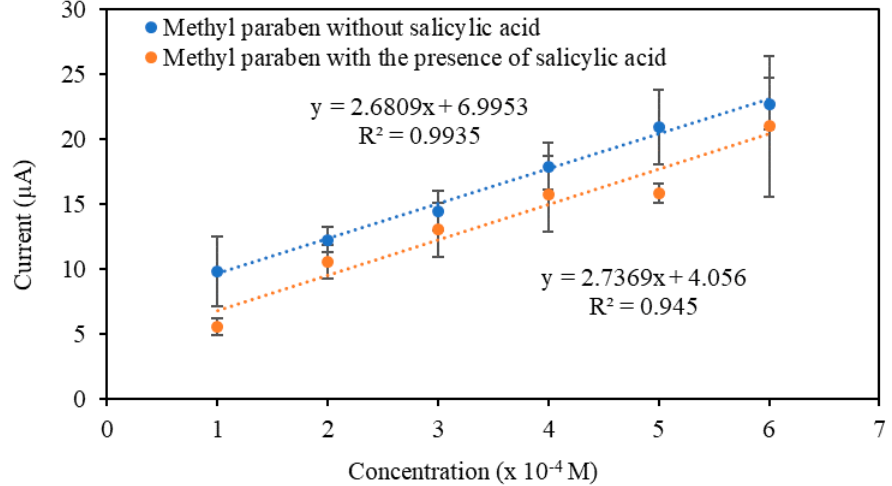
Figure 9. Linear calibration plots of CNC–rGO in MP solution with and without the presence of salicylic acid (SA) solution. SA solution was added only at two concentrations, i.e., 3 × 10 − 4 M and 5 × 10 − 4 M for MP concentrations of 3 × 10 − 4 M and 5 × 10 − 4 M, respectively. Table 2. Comparison of point-based linear range of MP without any addition of salicylic acid and with addition of salicylic acid at only two different concentrations, 3 × 10 − 4 M and 5 × 10 − 4 M. Linear Range without Any Addition of Salicylic Acid Linear Range with Addition of Salicylic Acid